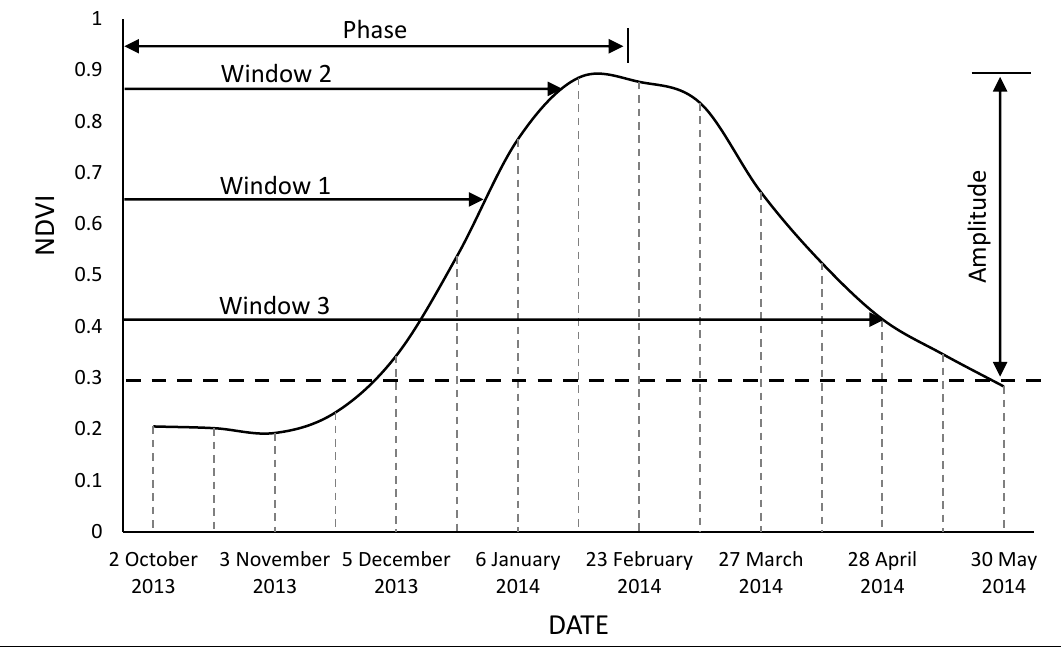
Figure 3. Example of windows selected for each classification model in the 2013 / 2014 season. Window 1 indicates the first model time-period from (1 October 2013 to 1 January 2014), Window 2 indicates the second model time-period from (1 October 2013 to 1 February 2014). Window 3 indicates the third model time-period from (1 October 2013 to 1 May 2014). The dashed line set to 0.3 is the Normalised Difference Vegetation Index (NDVI) threshold to detect cotton. Phase and amplitude were calculated within each window (one phase and one amplitude per window).